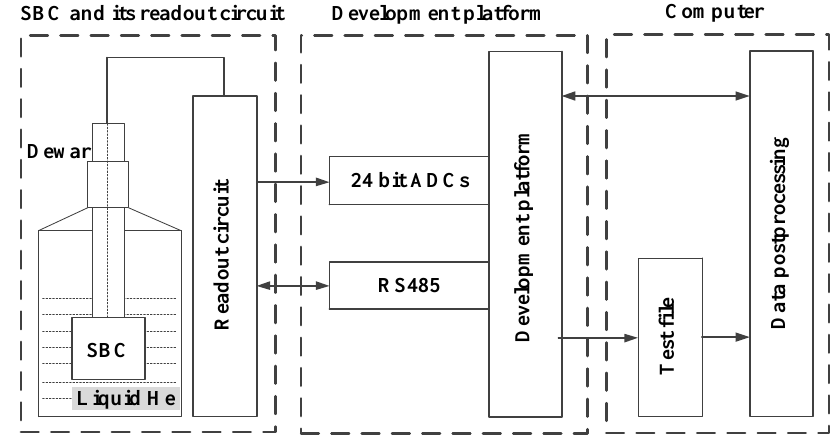
Figure 1. The diagram of the low-temperature superconducting quantum interference device (SQUID)